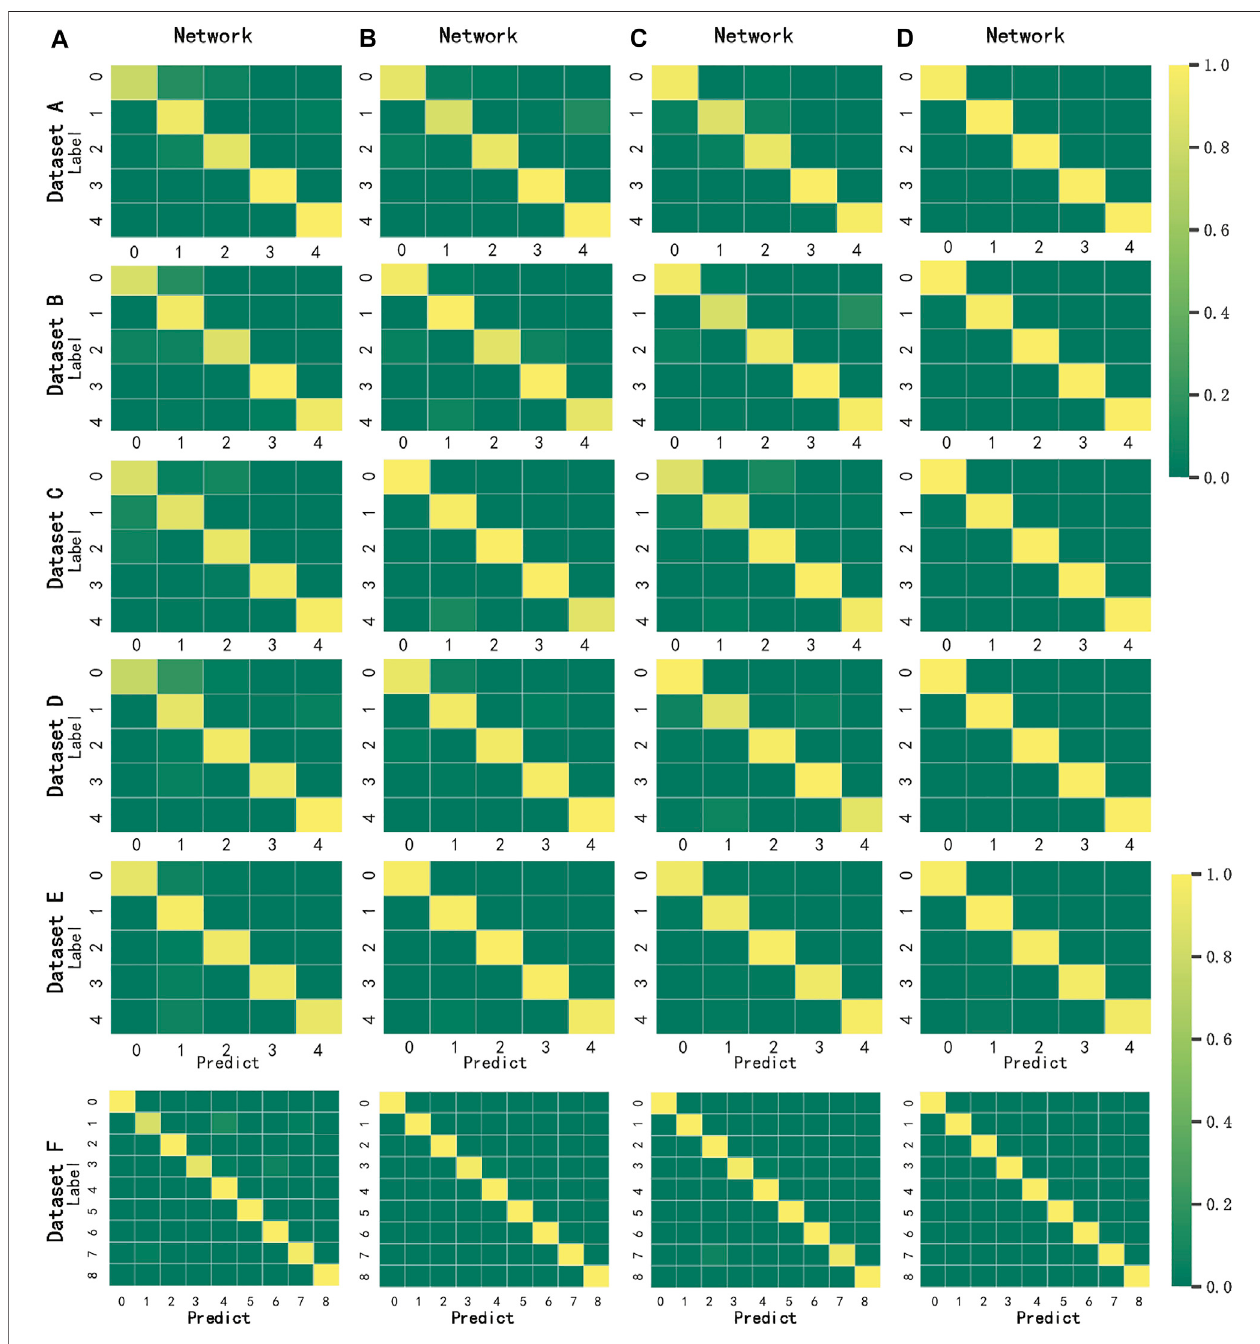
FIGURE 9 | Confusion matrix of the diagnosis accuracy obtained by different